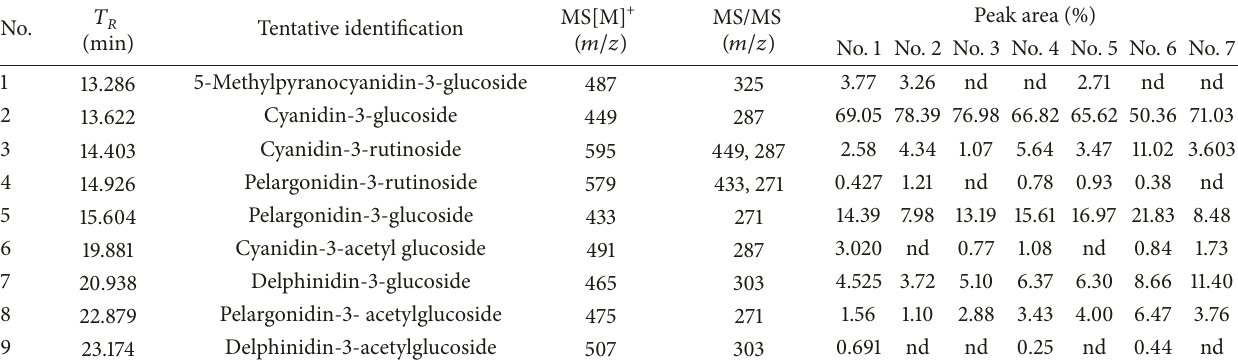
Table 2: The anthocyanins identified and the corresponding peak area percentages in anthocyanin extracts of different genotypes of Chinese dwarf cherry, Cerasus humilis (Bge.)